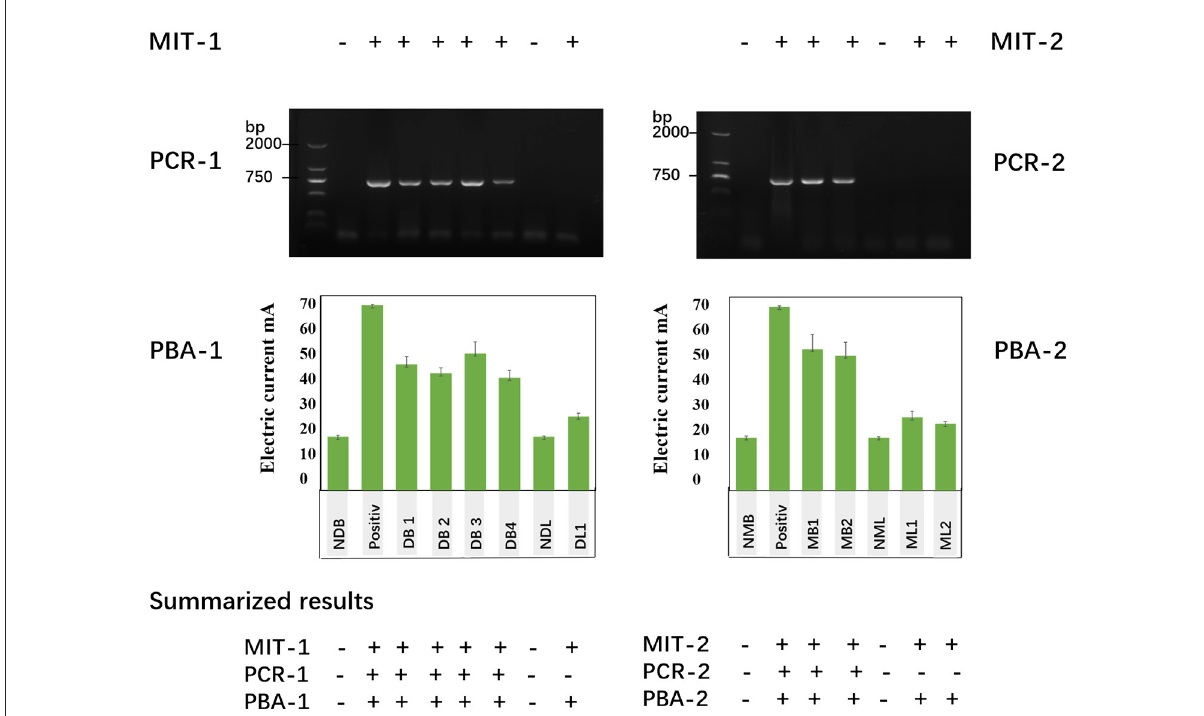
FIGURE6 Tissue samples were detected using MIT, RT-PCR, and a photoelectrochemical biosensor approach (PBA). MIT-1, PCR1, and PBA1 represents the detection results from dog brain and lung samples. Positive indicates the positive control from the standard rabies virus strain (CVS-24)-infected cell samples. The other samples include brain samples of four dogs (DB1, DB2, DB3, and DB4), a normal dog lung sample (NDL), and a dog lung sample (DL1, the same dog of DB1). MIT-2, PCR2, and PBA2 showed the detection results from mouse brain and lung samples. Positive indicates the standard rabies virus strain (CVS-24)-infected cell samples, two mouse brain samples (DM1, DM2), a normal mouse lung (NML), and two mouse lung samples (ML1,